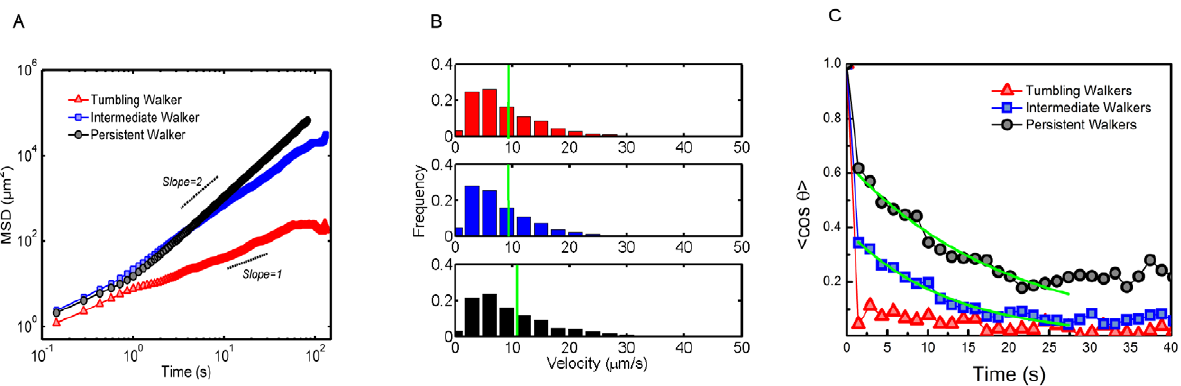
Figure 2. Similarities and diversity of trypanosome motion. (a) Mean squared displacement of typical swimmers for each mode (b) Population wide velocity distributions are virtually identical for all motility modes (derived from with profiling time 1/7 s). Mean velocity is shown in green. (c) Average cosine correlation function for each motility mode, exponential fits for persistence time shown in green. doi:10.1371/journal.pcbi.1002058.g002 PLoS Computational Biology |